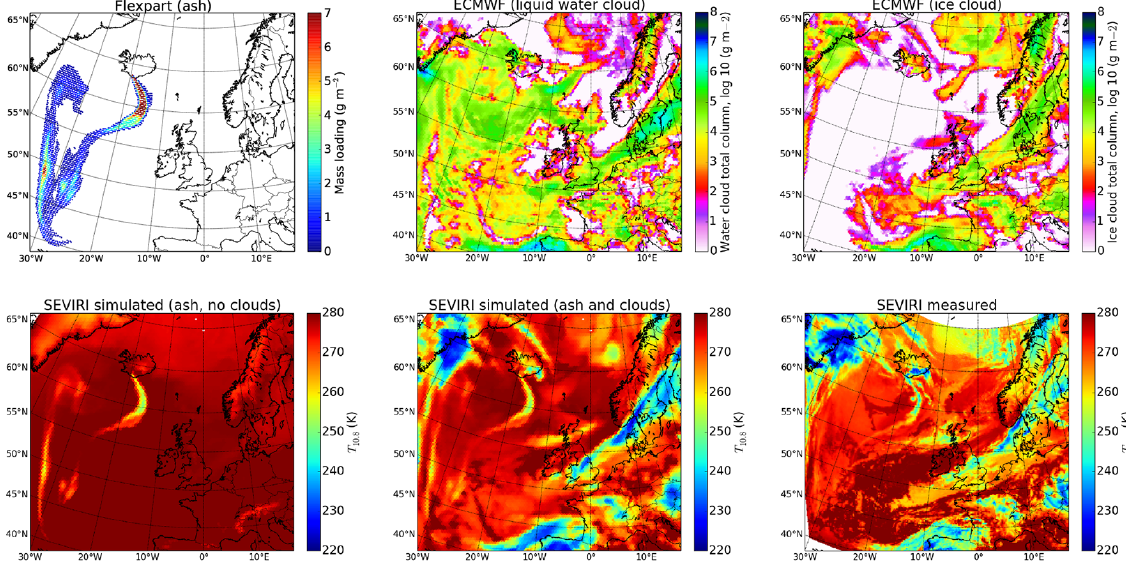
Figure 2. Same as Fig. 1, but for 18:00UTC, 8 May, 2010.